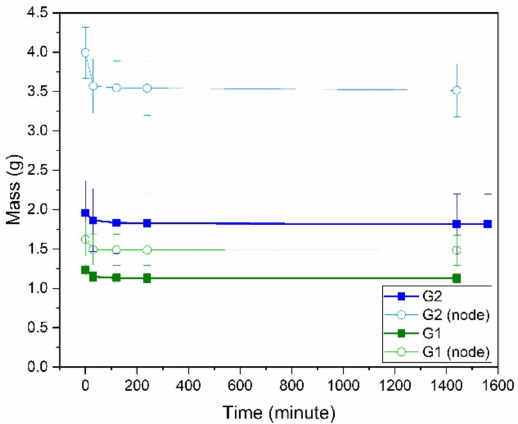
Figure 7. Mass loss of reed as a function of test time.